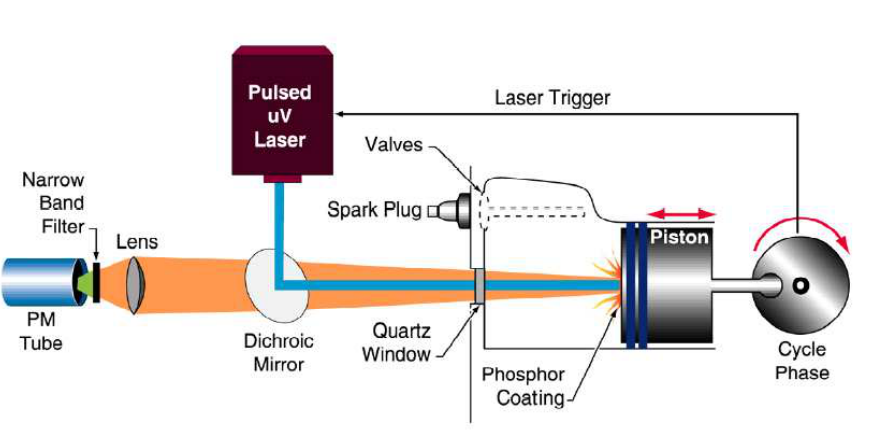
Figure 54. Schematic for piston measurements [53].